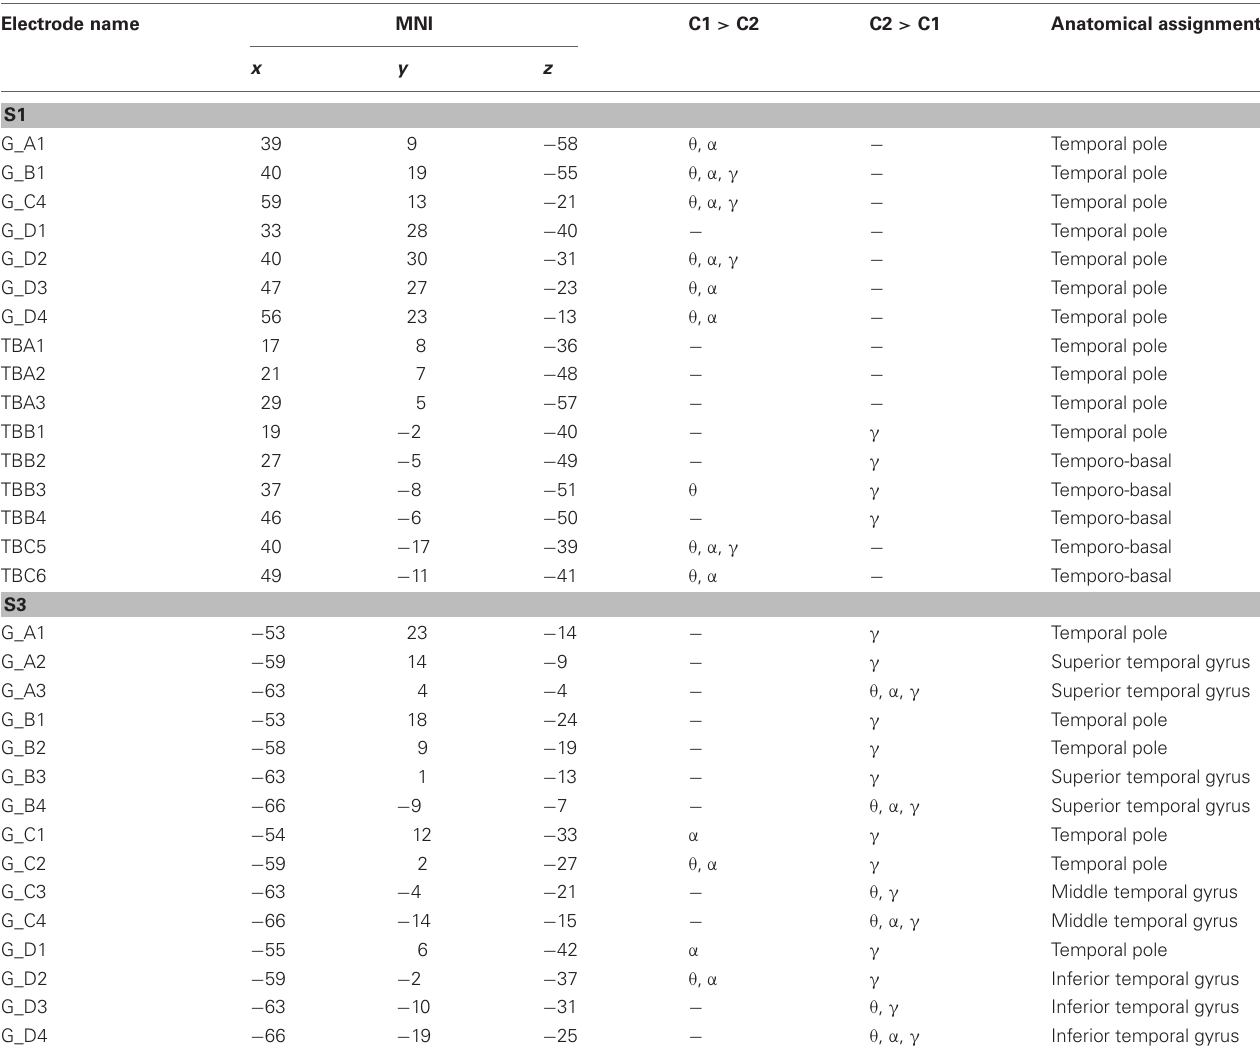
Table A1 | Statistically significant effects ( p < 0 . 001, FDR) in the theta ( θ ), alpha ( α ), and gamma ( γ ) frequency band, MNI coordinates, and anatomical locations of ATL electrodes in S1 and